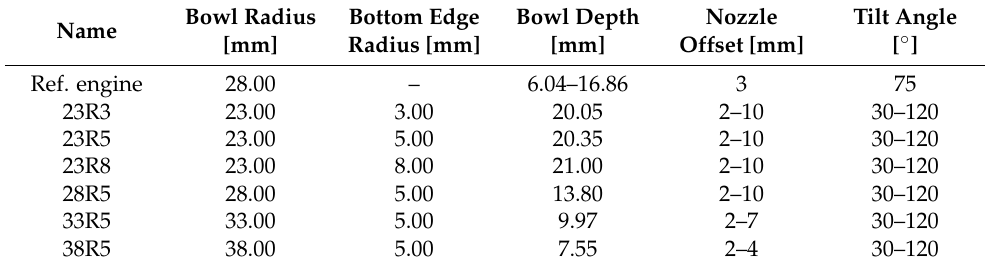
Figure 3. Bowl geometries. Table 6. Details of the analyzed combustion